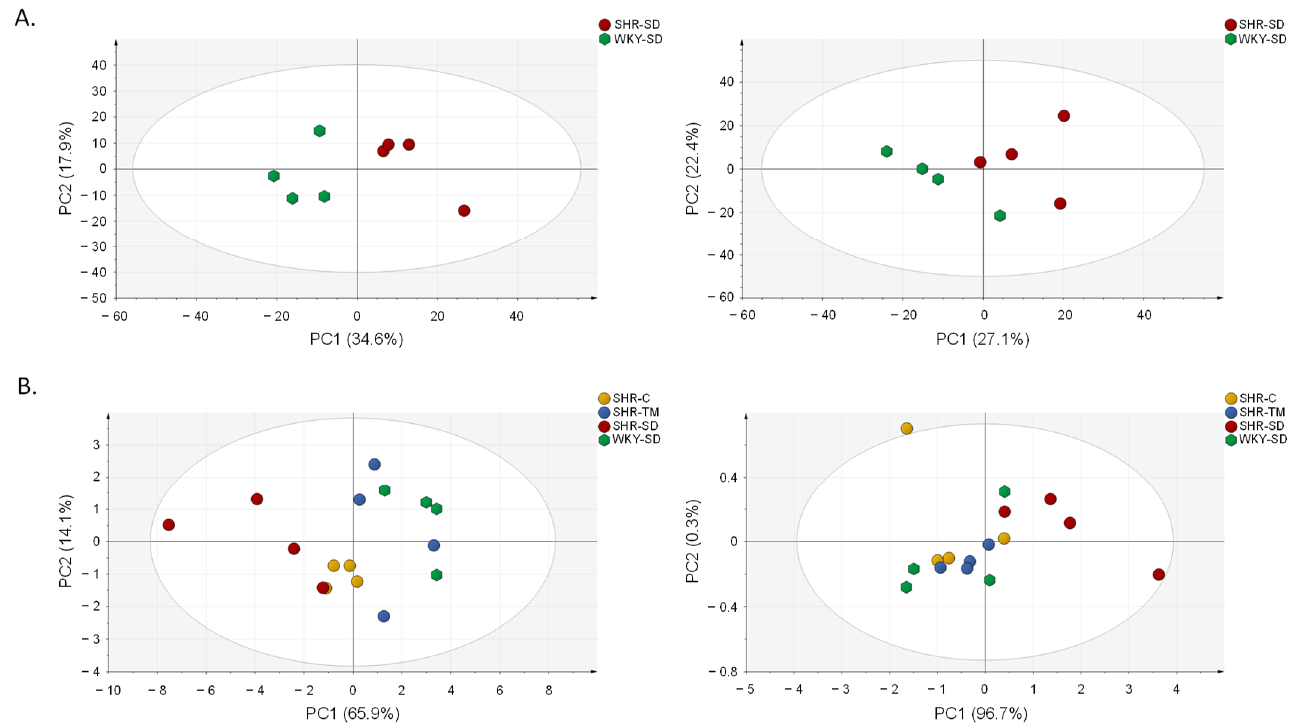
Figure 2. ( A ) Unsupervised PCA performed on metabolomics data from SHR-SD and WKY-SD rats acquired in negative (left) and positive ionization mode (right). The groups are clearly separate on the basis of their global metabolomics profile. ( B ) Unsupervised PCA performed on quantitative data from 15 metabolite targets of intervention by supplementation with protein extracts from TM, 13 of which were acquired in negative (left) and 2 in positive ionization mode (right). Animals of the SHR-SD group are clustered separately from SHR-C and SHR-TM along the first component, indicating that these two groups have a metabolomics pattern closer to that of WKY-SD than to that of SHR-SD.